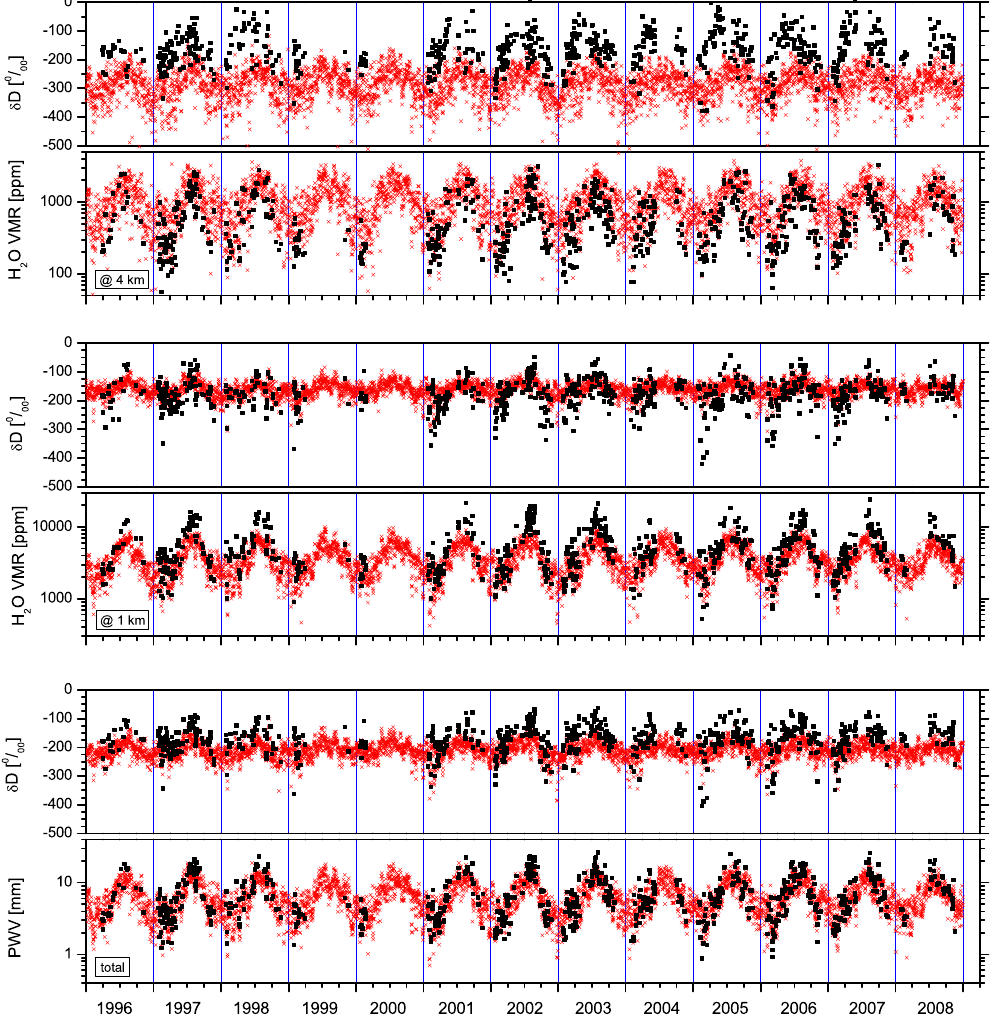
Fig. 1. Kiruna H 2 O and δ D time series. Black squares: ground-based FTIR measurements; Red crosses: IsoGSM simulations; Panels from the bottom to the top: column integrated atmosphere, lower troposphere (altitude of 1km), middle troposphere (altitude of 4km).